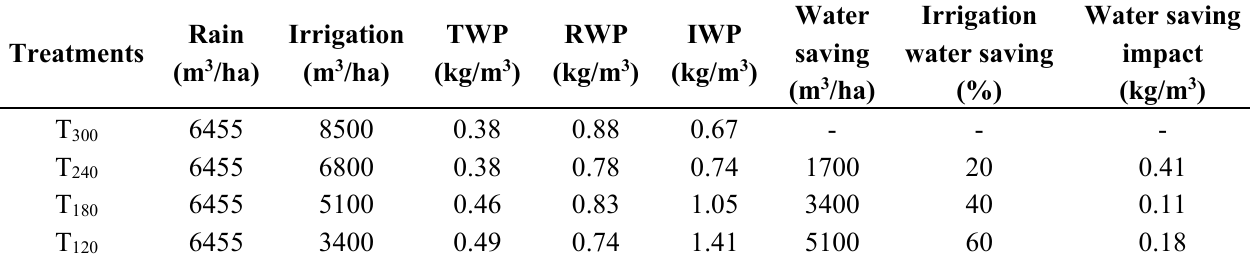
Table 5. Effects of treatments on water use